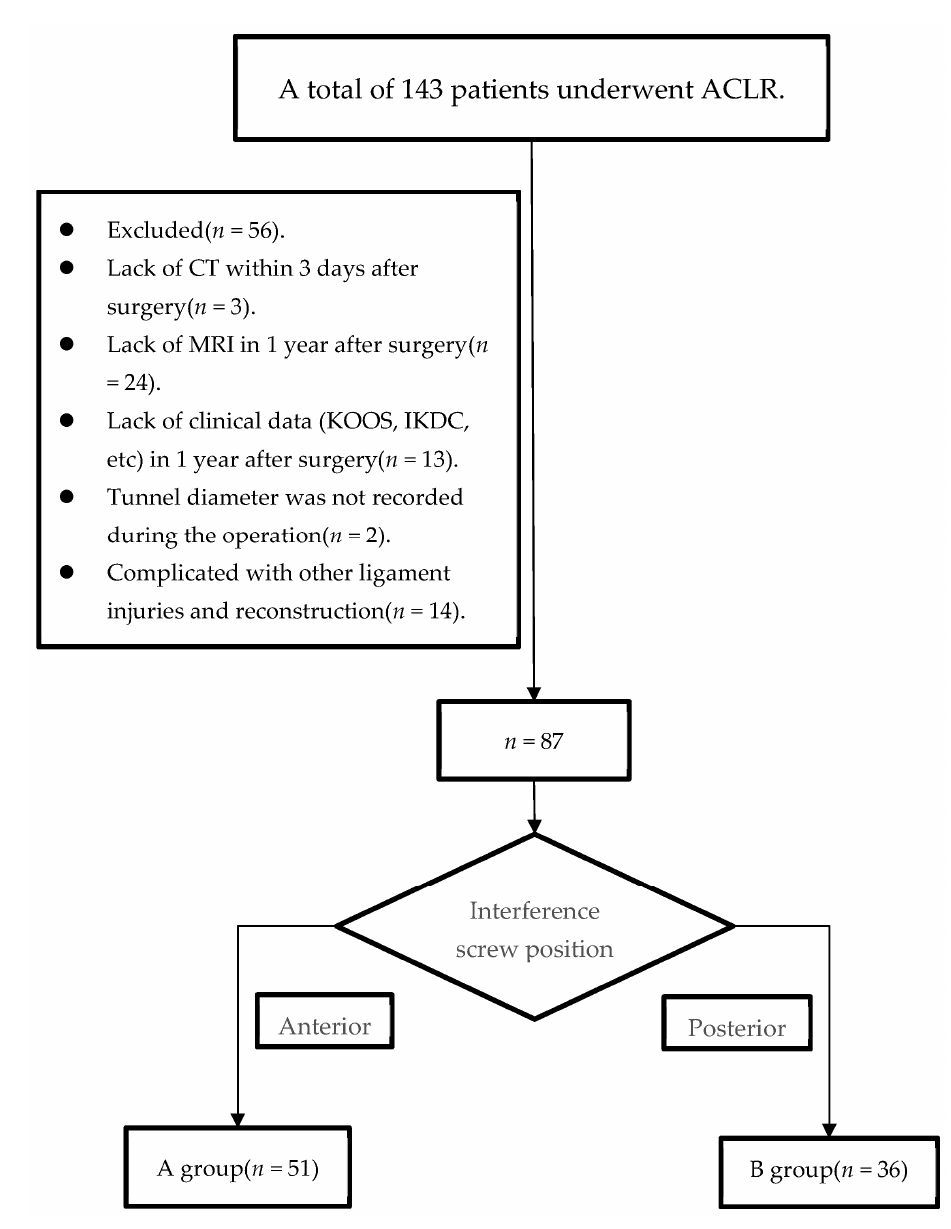
Figure 1. Patient flowchart. (ACLR, anterior cruciate ligament reconstruction; KOOS, knee injury and osteoarthritis outcome score; IKDC, international knee documentation committee score; CT, computed tomography).